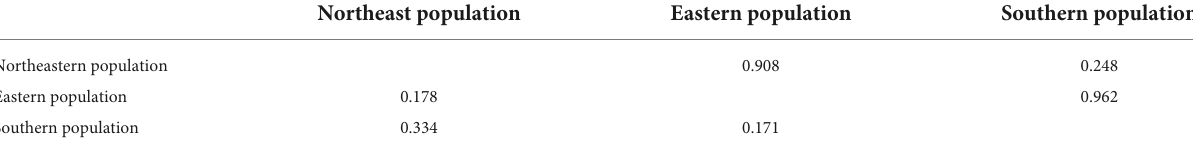
TABLE 2 Pairwise comparisons of gene flow ( Nm , above diagonal) and genetic differentiation ( F ST , below diagonal) of Fusarium proliferatum populations. Northeast population Eastern population Southern population 0.908 0.248 0.962